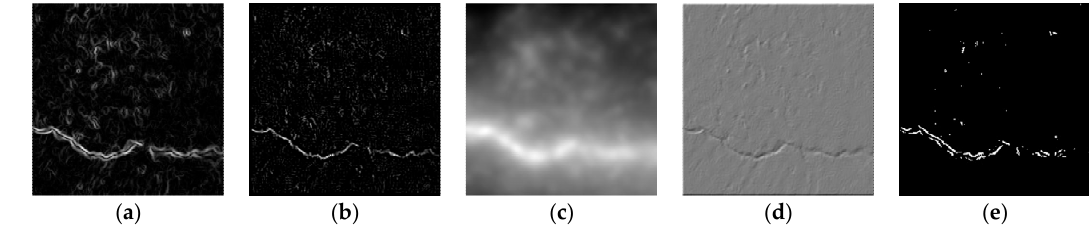
Figure 4. Crack edge detection results of image with longitudinal crack using different filters: ( a ) Sobel; ( b ) LoG; ( c ) Gabor; ( d ) steerable; ( e ) homogeneity.